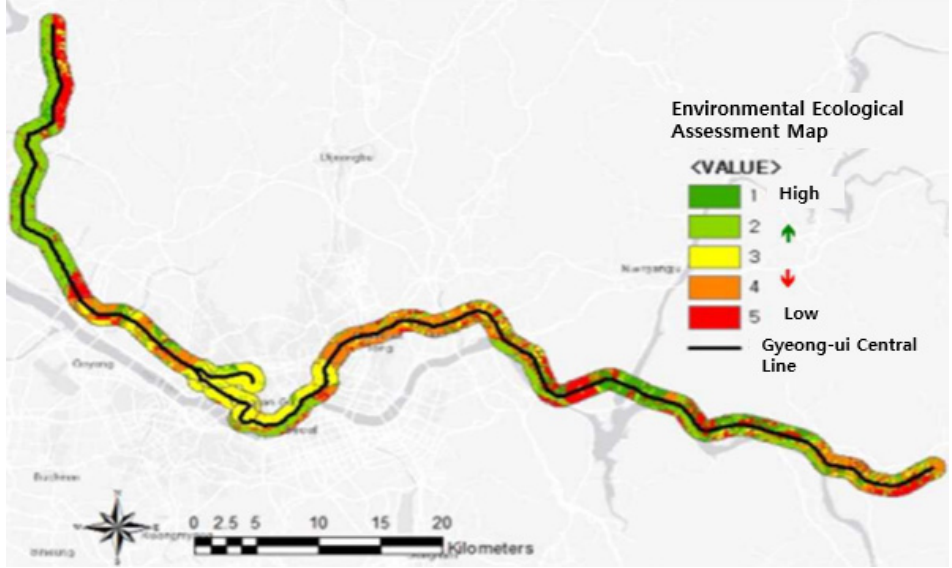
Figure 3. Environmental quality evaluation map of the Gyeong-ui Central Line.